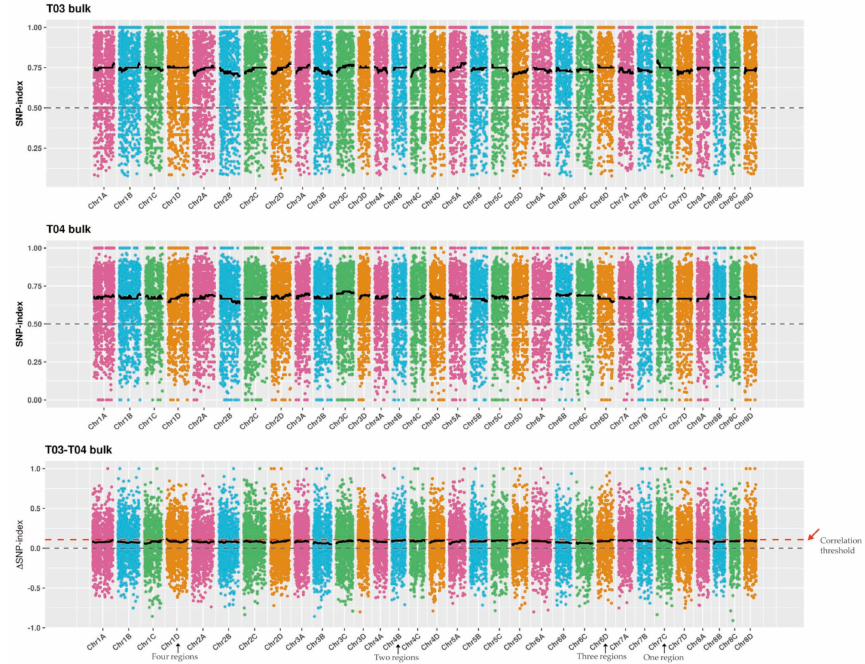
Figure 3. The distribution of correlation thresholds of ∆ SNP-index on the chromosome of Saccharum spontaneum . The abscissa is the chromosome name, and the ordinate is the SNP-index value (or ∆ SNP-index value); the colored dots represent the SNP-index value (or ∆ SNP-index value) on the chromosome, the black line represents the fitted SNP-index value (or ∆ SNP-index value), and the red arrow represents the correlation